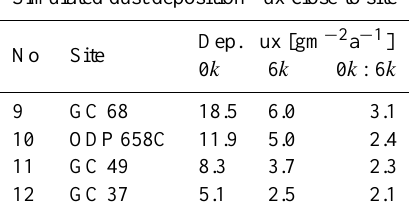
Table 5. Simulated dust deposition flux close to site GC68, ODP 658C, GC49 and GC37 (Table 4) for 0 k and 6 k and the correspond- ing flux ratios between 0 k and 6 k